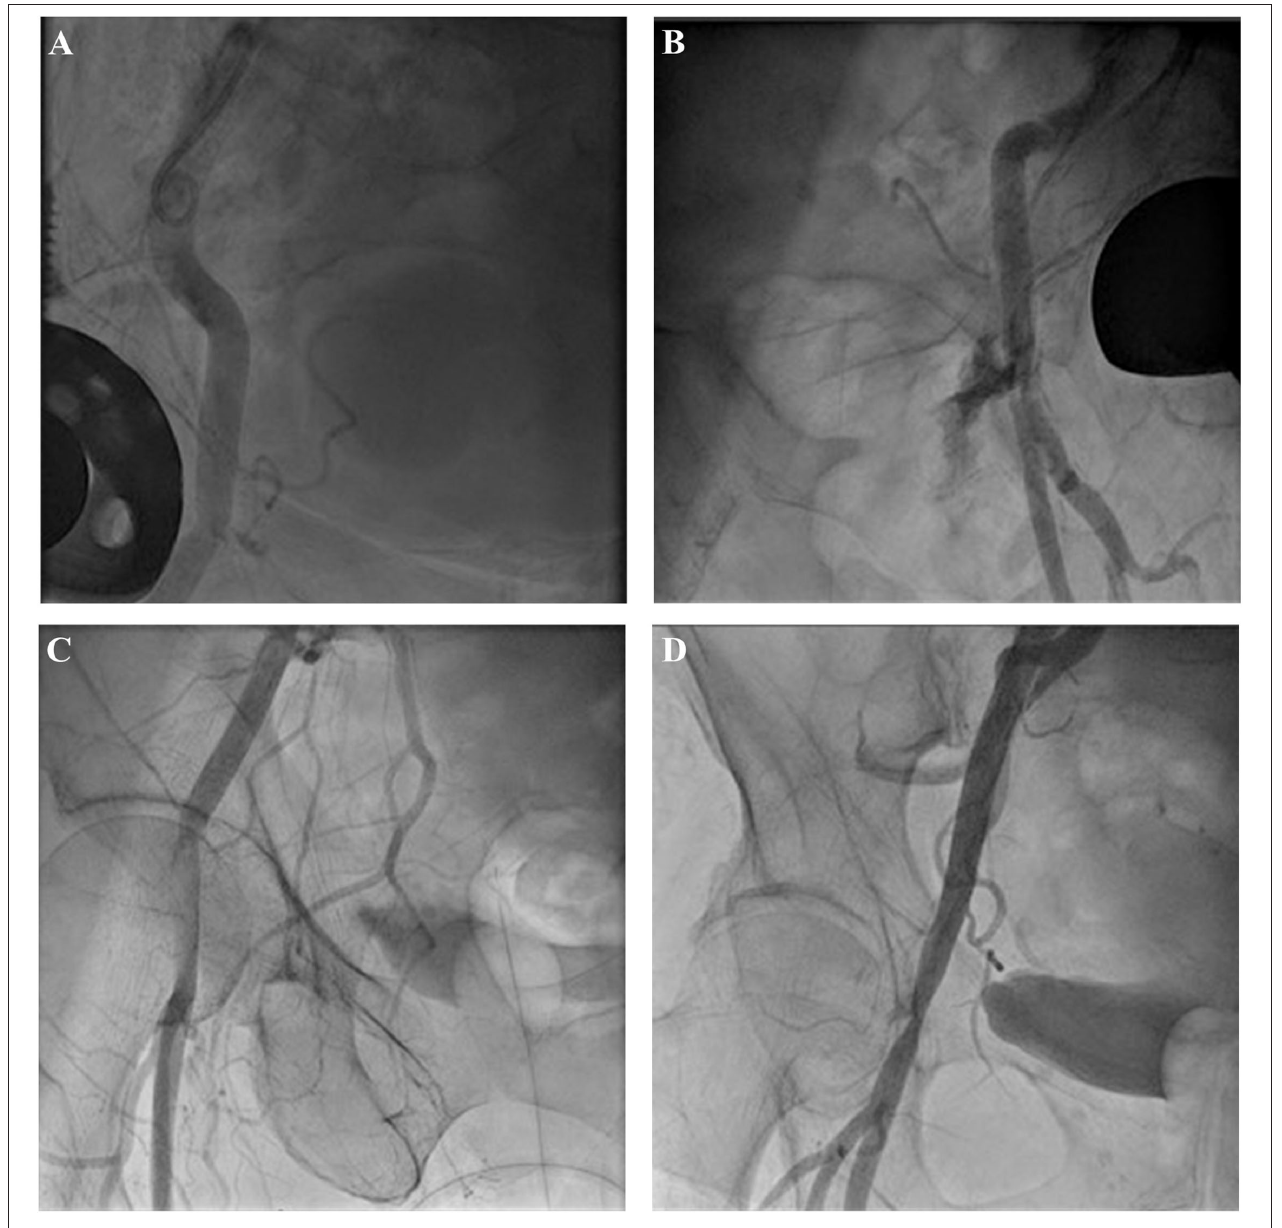
FIGURE 2 | Evaluation of angiogram after use of closure device: minor leak (A) , severe leak (B) , dissection (C) , and stenosis with minor leaks (D) .